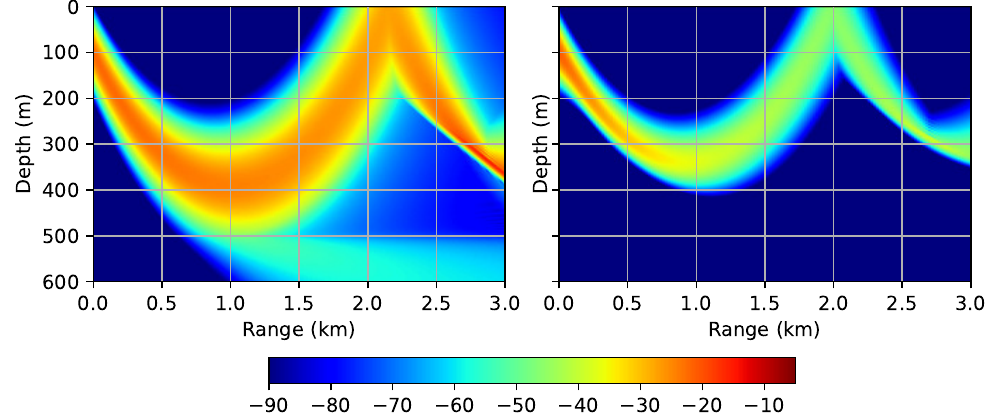
Figure 5. Waveguide with an inhomogeneous refractive index. Acoustic pressure distribution (20log | ψ | ). ∆ x = 6 m, ∆ z = 0.07 m, c 0 = 1806 m/s ( left ) and ∆ x = 20 m, ∆ z = 0.07 m, c 0 = 1806 m/s ( right ).